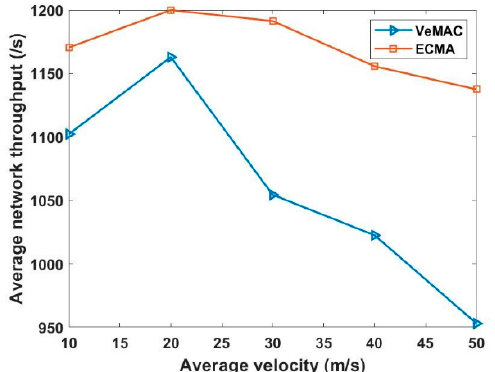
Figure 9. Average network throughput versus average velocity.